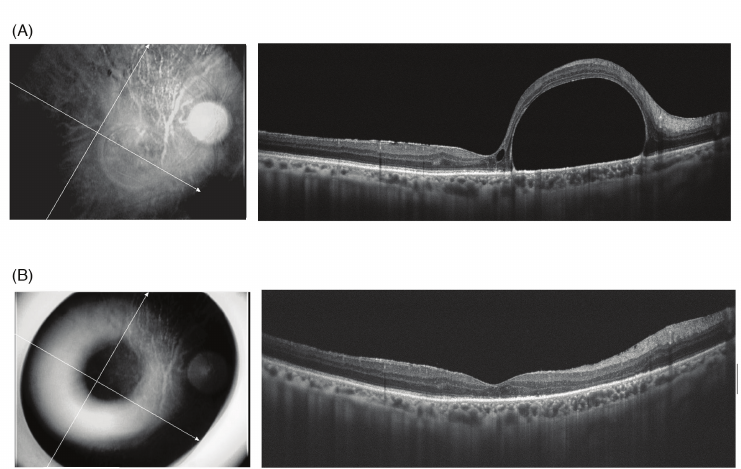
Figure 3. (A) Preoperative optical coherence tomography (OCT) image demonstrating large subfoveal perfluorocarbon liquid bubble, distorting normal foveal contour. (B) Postoperative OCT image, one month after surgery, confirms the complete removal of perfluorocarbon liquid